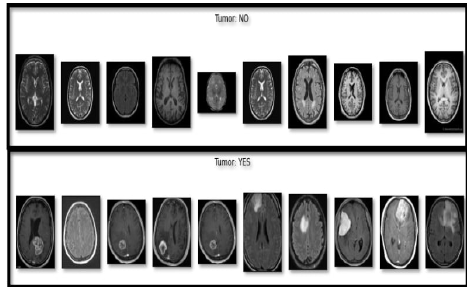
Figure 3. Kaggle Dataset [16]